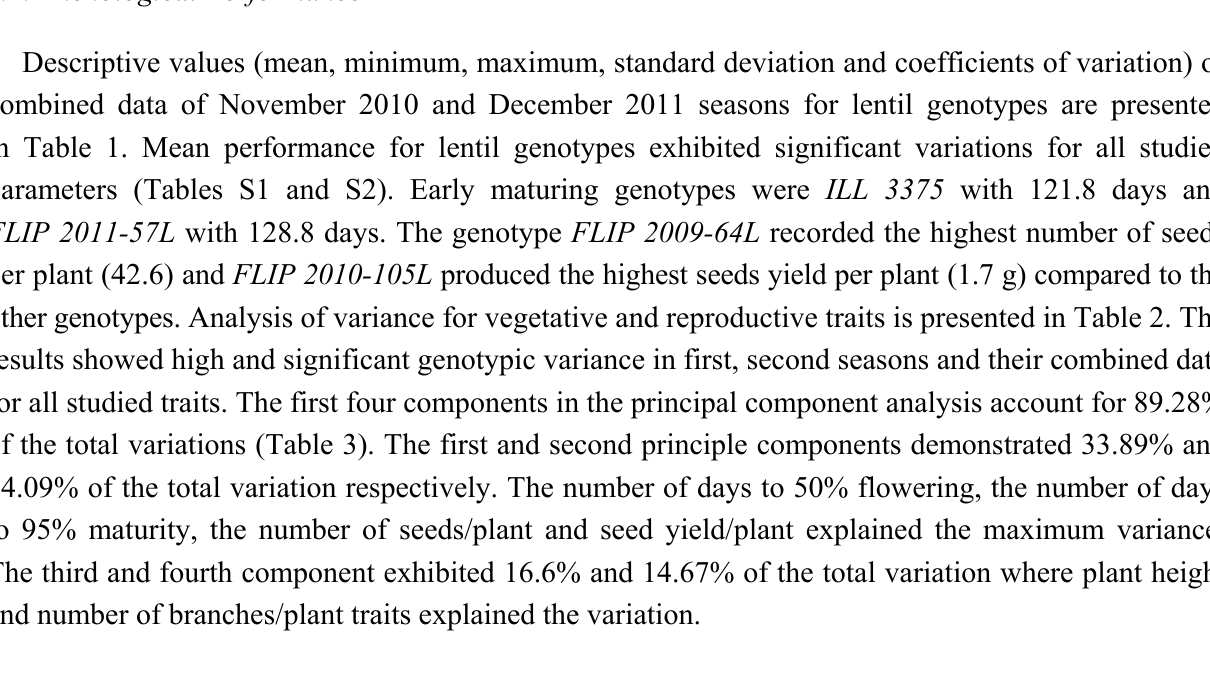
Table 1. Mean, minimum and maximum values, standard deviation (SD) and coefficient of variability (CV) of vegetative and reproductive studied traits for combined data of the two seasons (2011 and 2012) for 35 lentil studied